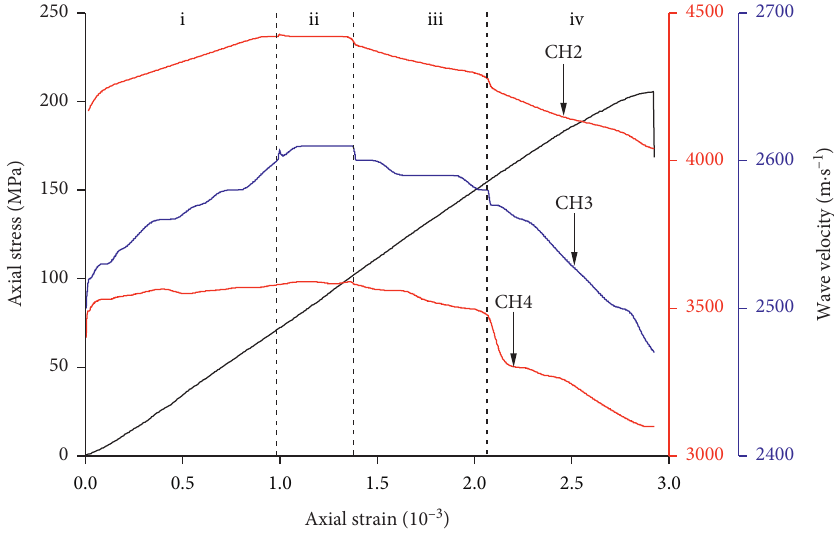
Figure 6: Ultrasonic velocity of granite at three locations under uniaxial